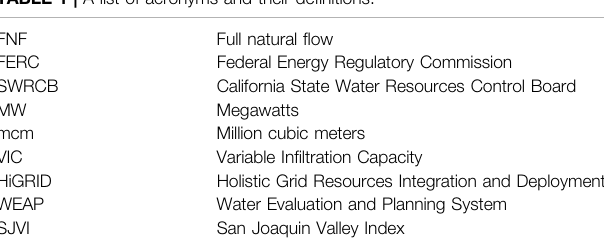
TABLE 1 | A list of acronyms and their de fi